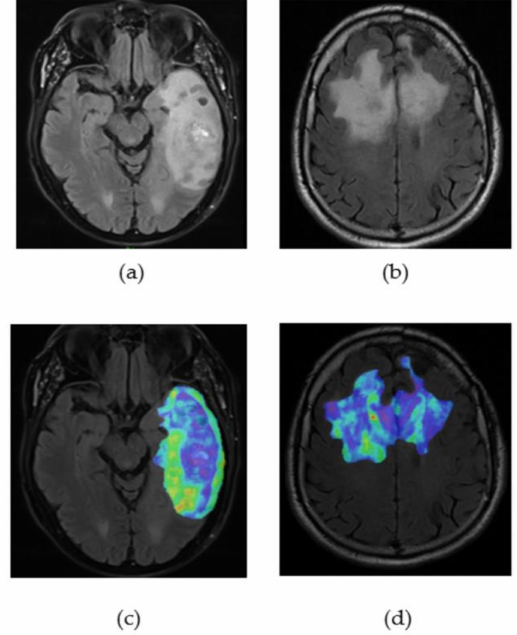
Figure 4. ( a ) FLAIR image of glioblastoma’s patient with a bad prognosis (OS = 3 months); ( b ) FLAIR image of glioblastoma’s patient with a good prognosis (OS = 30 months); ( c ) original neighbouring grey tone difference in matrix strength radiomic map of the segmented tumour on the patient with bad prognosis; ( d ) original neighbouring grey tone difference in matrix strength radiomic map of the segmented tumour on the patient with good